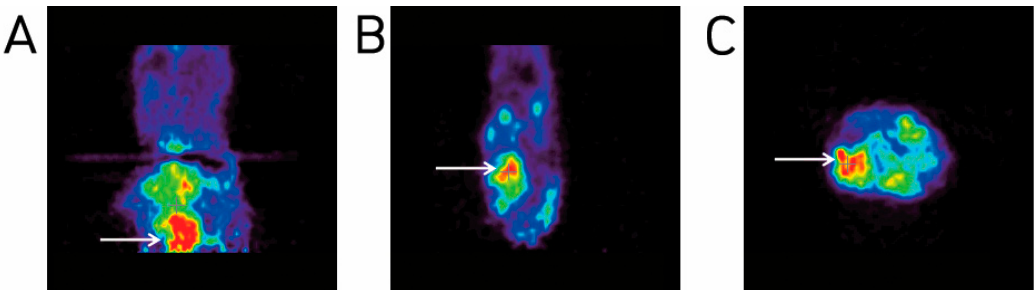
Figure 3. PET imaging of induced tumors: ( A ) Coronal; ( B ) sagittal and ( C ) transverse PET images of the injection sites show evidence of tumors. Tumors are shown in red (arrows).